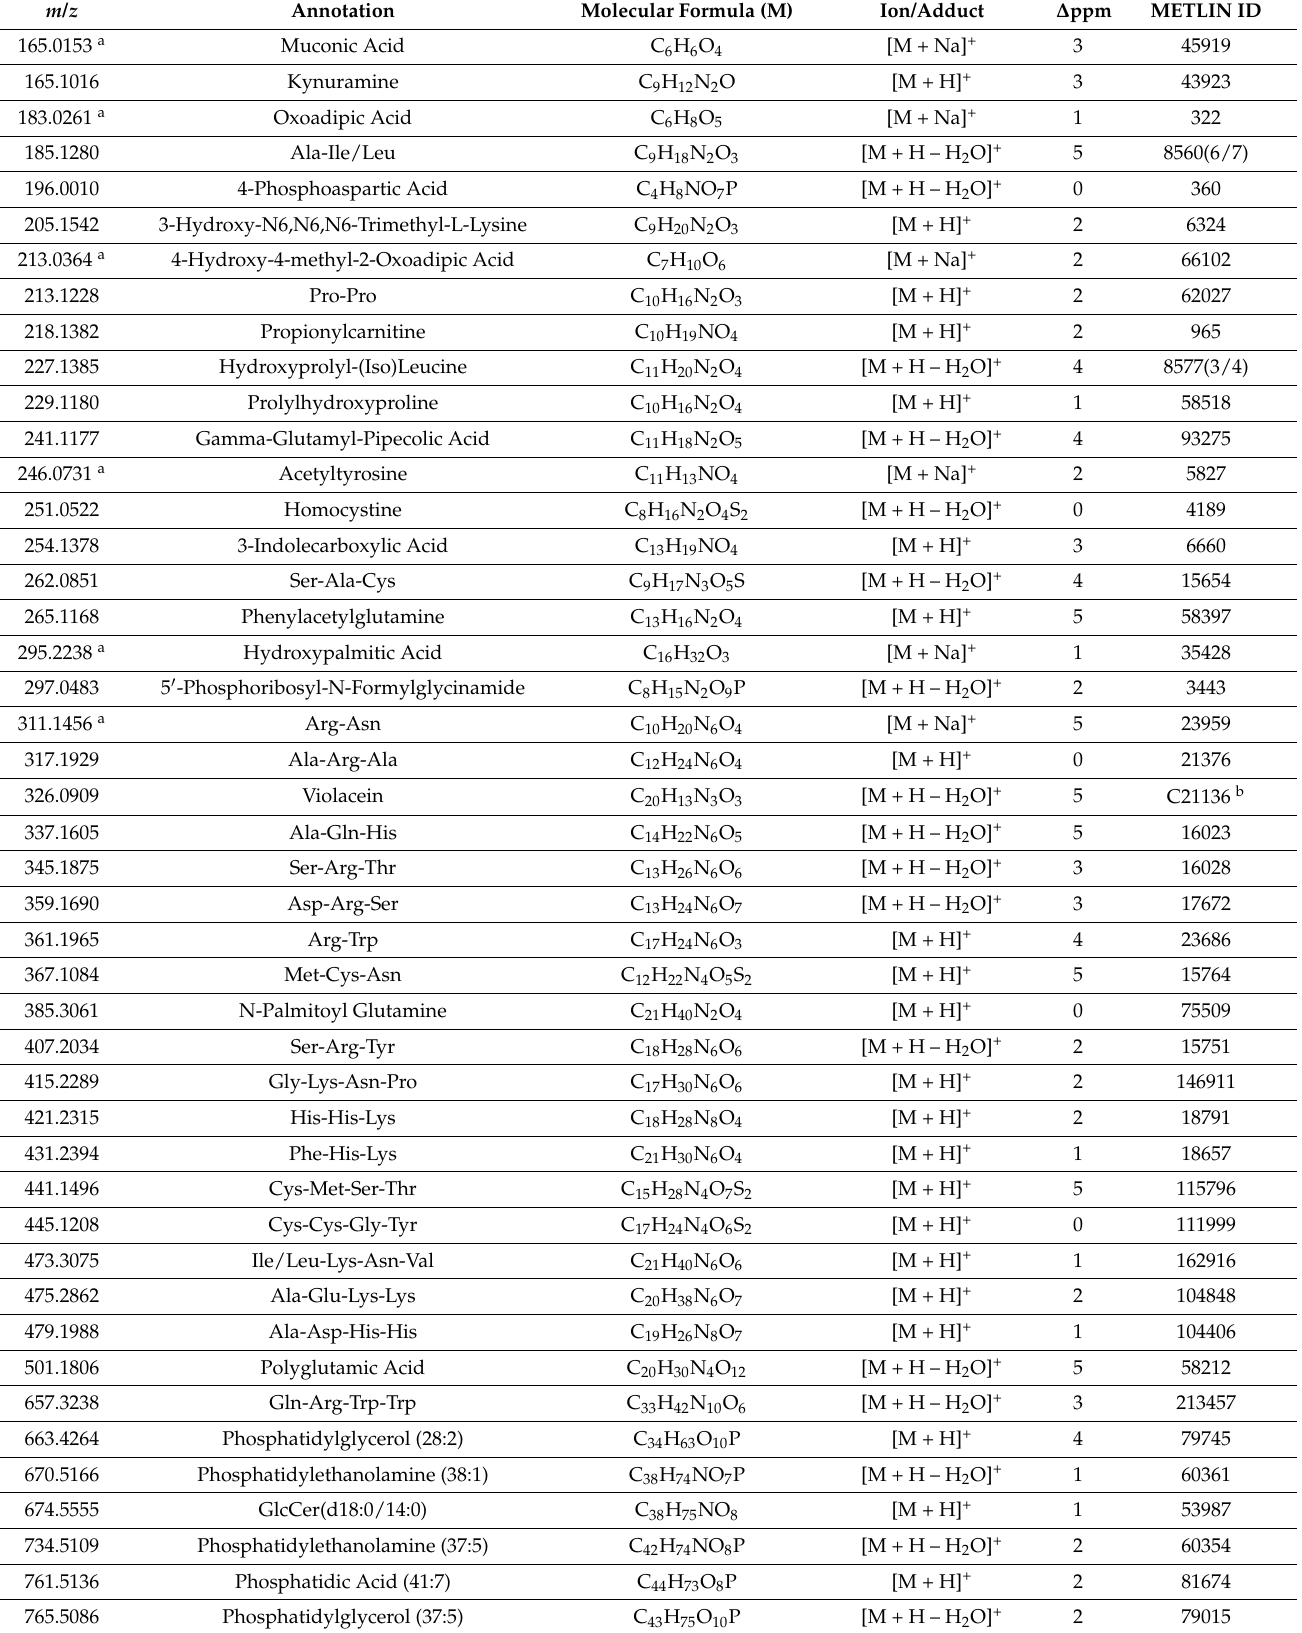
Table 1. Features detected exclusively in O. formigenes EV isolate compared to an EV-free control. Putative IDs (MSI Level 2) made by accurate m/z matching to METLIN database ( ≤ 5